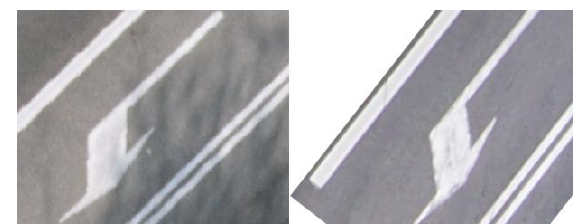
Figure 10. Comparison of images taken from the aircraft (left) and UAV (right) for the same area – a selected roads. Images from UAV have been rotated to obtain a similar position of the road.